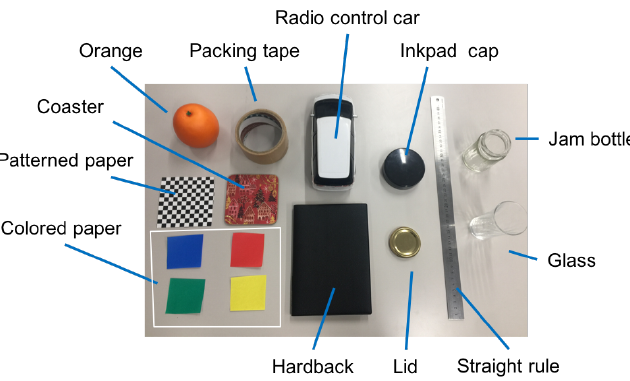
Figure 12. Physical objects used in the online